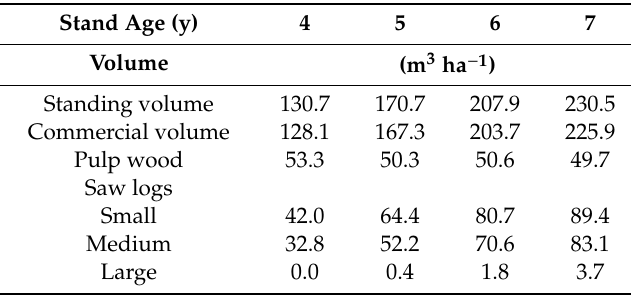
Table 2. The total volumes of commercial wood produced and estimated amounts in di ff erent log classes (products) in the third rotation stand from age four to harvest.